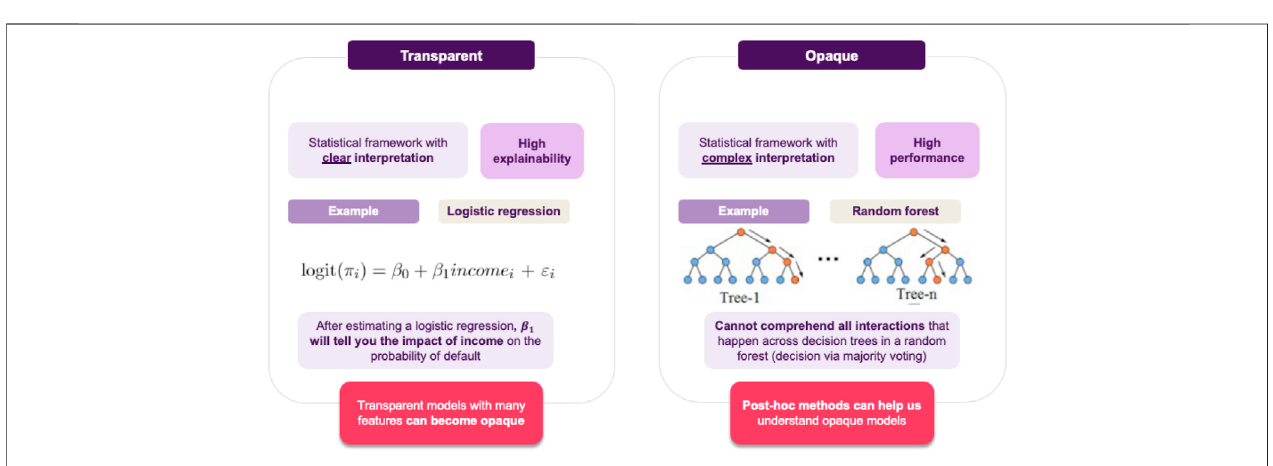
FIGURE 4 | Jane ’ s choices: should she go for a transparent model or an opaque one?